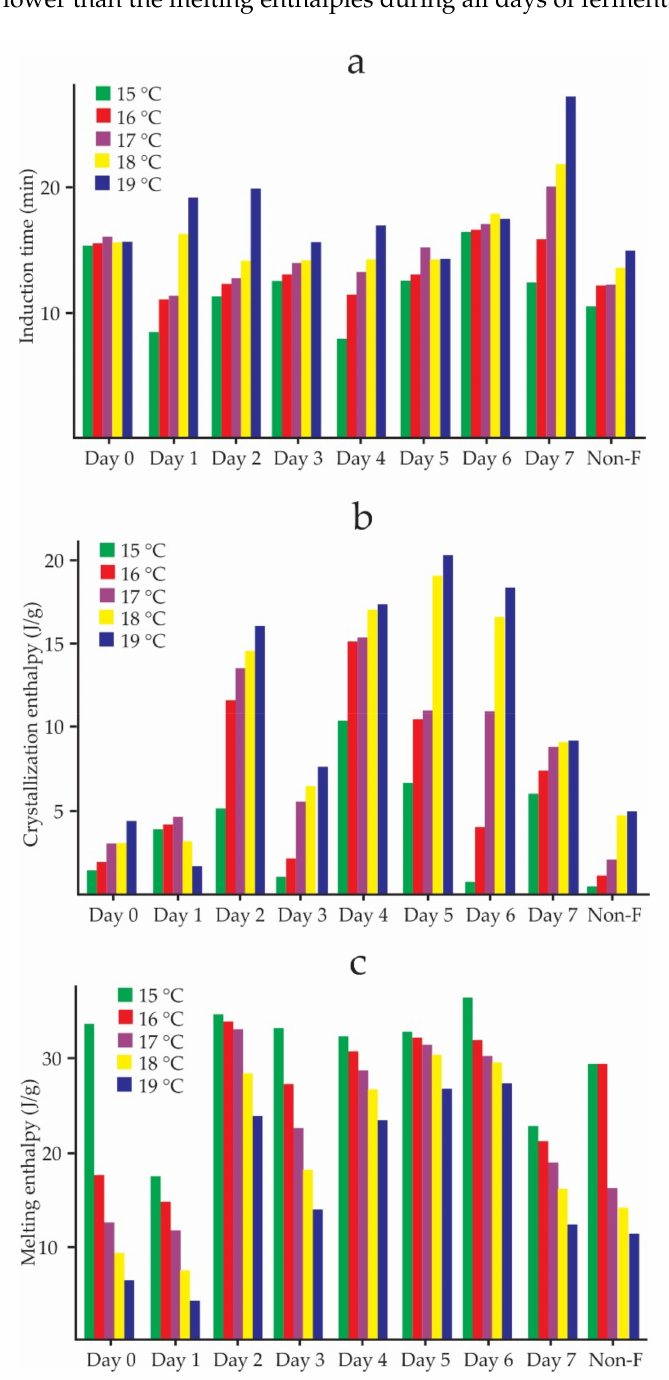
Figure 4. Induction times ( a ), crystallization enthalpy ( b ), and melting enthalpy ( c ) of the CB inside cocoa beans as a function of spontaneous fermentation